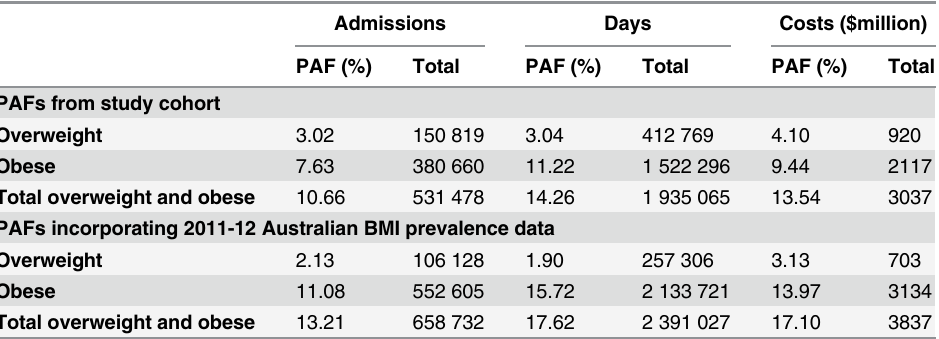
Table 5. Hospitalisation burden attributable to overweight and obesity in the study cohort and the Australian population aged 45 – 79 years in 2011 –